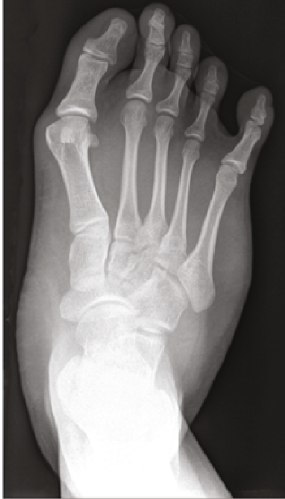
Figure 2: Preoperative anteroposterior radiograph.